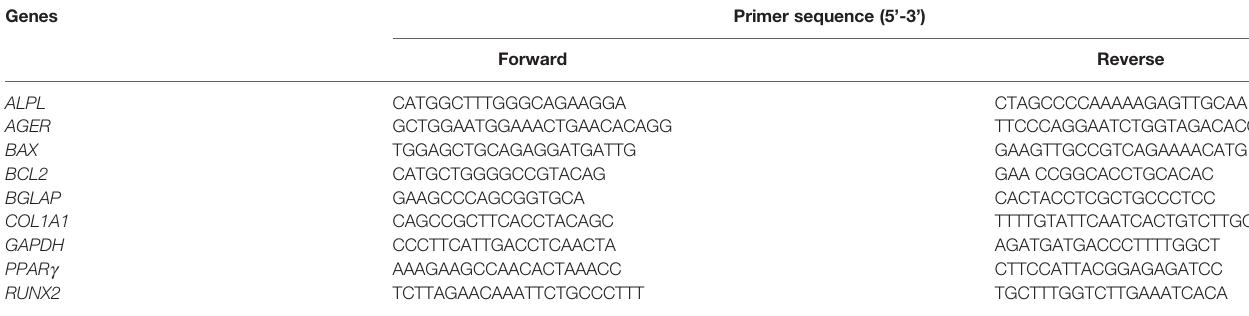
TABLE 1 | Sequences of real-time qPCR